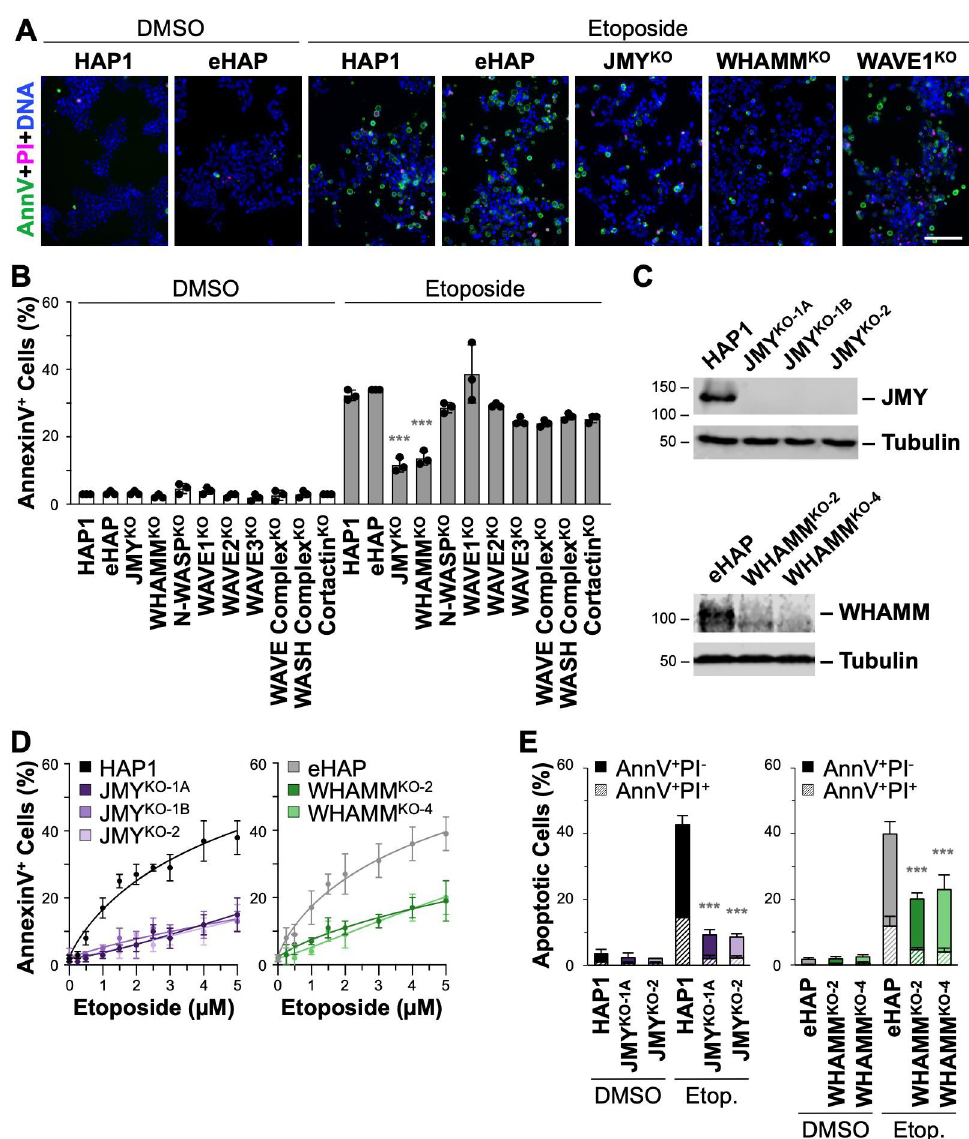
Fig 1. Cells lacking the WASP-family members JMY or WHAMM undergo less apoptosis following DNA damage. (A) Parental (HAP1, eHAP) and WASP-family knockout (JMY KO-1A , WHAMM KO-2 , N-WASP KO , WAVE1 KO , WAVE2 KO , WAVE3 KO , WAVE Complex KO , WASH Complex KO , Cortactin KO ) cells were treated with DMSO or 5 μ M etoposide for 6h and stained with Alexa488-AnnexinV (AnnV; green), Propidium Iodide (PI; magenta), and Hoechst (DNA; blue). Scale bar, 100 μ m. (B) The % of AnnV-positive cells was calculated in ImageJ by dividing the number of cells that displayed AnnV staining by the total number of cells identified by nuclear Hoechst staining. Each point represents the mean from 3 fields-of-view in 3 separate experiments, and the bar represents the mean ± SD of those experiments (n = 391–1,303 cells per point; n = 1,772–3,619 cells per bar). The uppermost WAVE1 KO point was significantly different from HAP1 cells in one experiment. (C) HAP1, JMY KO , eHAP, and WHAMM KO cell lysates were immunoblotted with antibodies to JMY, WHAMM, and tubulin. (D) HAP1, JMY KO , eHAP, and WHAMM KO cells were treated with a range of etoposide concentrations for 6h and then stained with Alexa488-AnnV and Hoechst. The % of AnnV-positive cells was calculated in ImageJ. Each point represents the mean ± SD from 3–6 fields-of-view pooled from 1–2 experiments (n = 1,699–4,996 cells per experiment). Nonlinear regressions were performed with a baseline set to 0.02 and a maximum response set to 0.85. EC50 values were significantly different for parental vs KO samples (Mean EC50s: Parental = 6.2 μ M; JMY KO = 26.4 μ M, p < 0.001; WHAMM KO = 20.9 μ M, p < 0.001). (E) Cells were treated with DMSO or 5 μ M etoposide for 6h and stained with Alexa488-AnnV, PI, and Hoechst. The % of AnnV-positive cells is displayed as the fraction of AnnV- positive/PI-negative (AnnV + PI - ) or AnnV/PI double-positive (AnnV + PI + ) cells. Each bar represents the mean ± SD from 3 experiments (n = 2,338–9,846 cells per bar). All significance stars are for comparisons to the etoposide-treated HAP1 or eHAP cells. ��� p < 0.001 (ANOVA, Tukey post-hoc